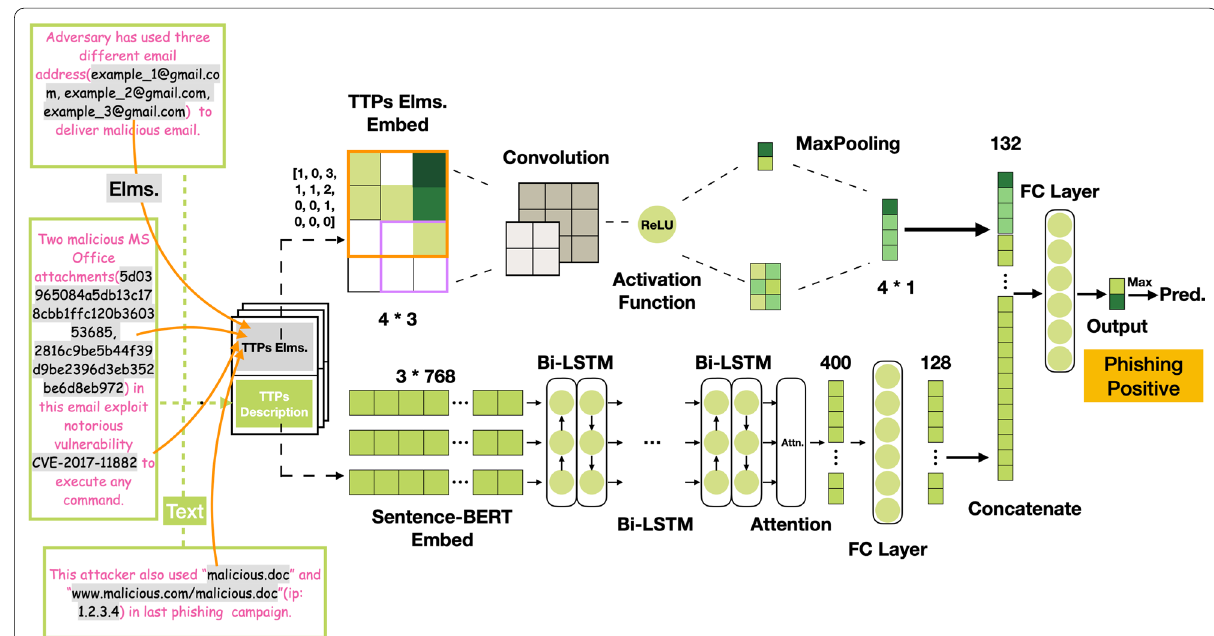
Fig. 4 The TCENet architecture. The upper path uses CNN and max-pooling to extract element features, and the lower path uses stack-BiLSTM attention to extract text features. A fully connected layer is used to obtain the final feature vector after concatenating the result of two